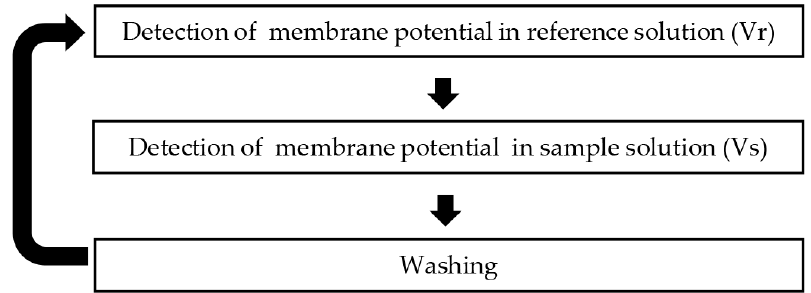
Figure 3. Measurement procedure for the taste sensor. Figure 2. Structure of sensor and reference electrodes.